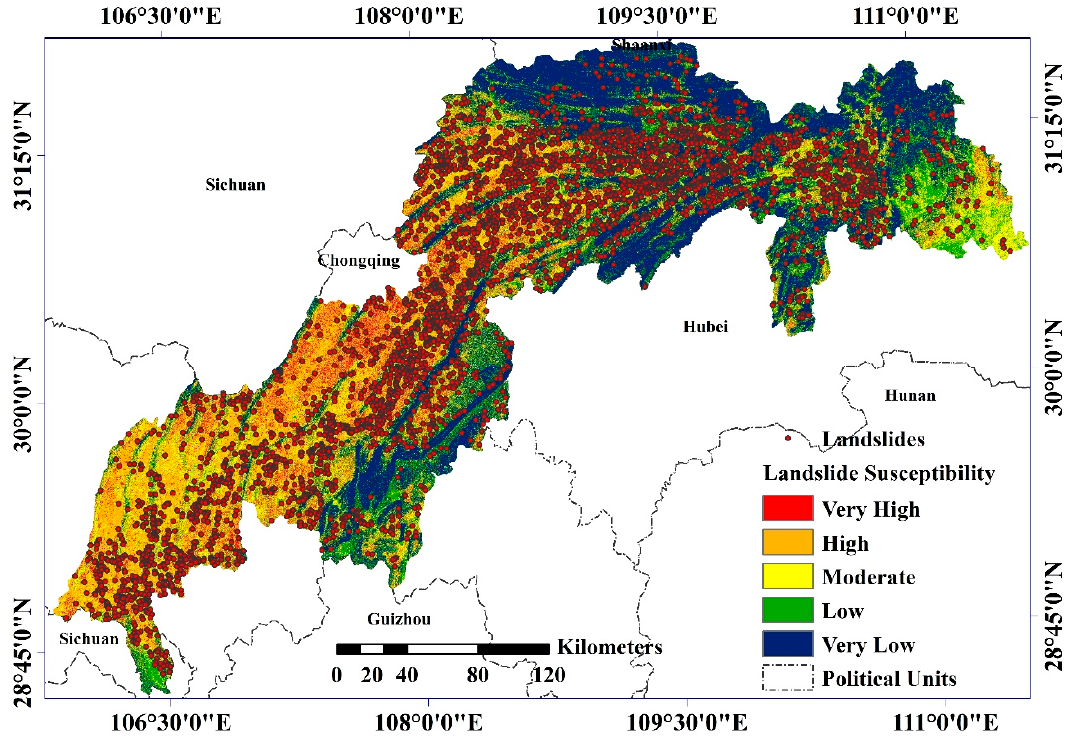
Figure 10. Landslide susceptibility map and historical landslide occurrence distribution in the Three Gorges Reservoir area.